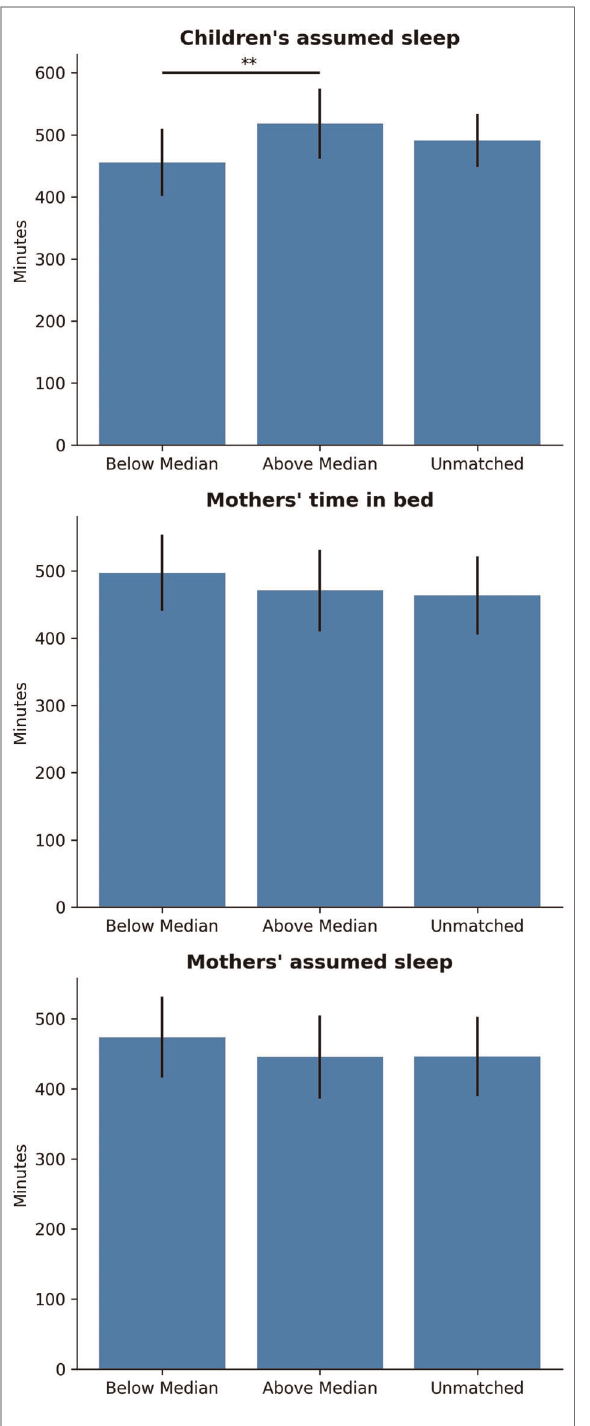
FIGURE 1 Comparison of sleep variables by group (matching of mother-child sleep). (cid:2) p , : 05, (cid:2)(cid:2) p , : 0014.